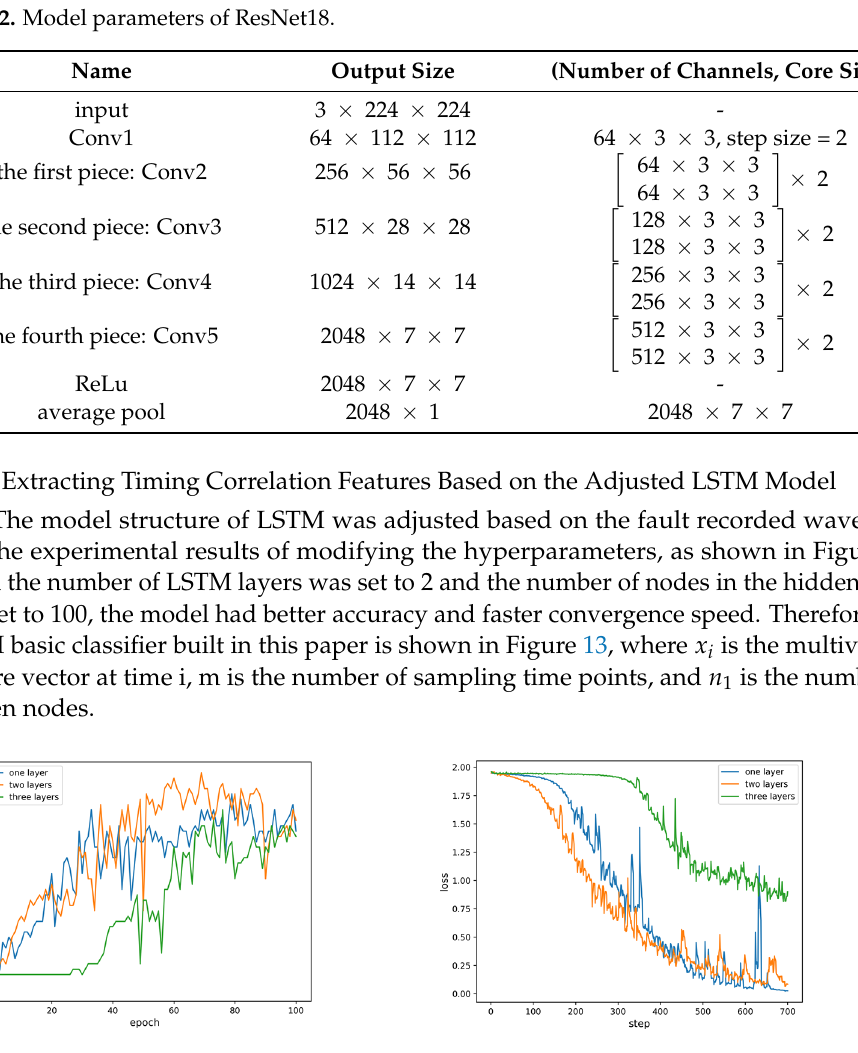
Figure 13. LSTM basic learner structure. The two basic classifiers can be trained in parallel, and the loss functions are both cross-entropy loss functions. 3.2.4. Construction of the Secondary Data Sets and Fusion Models For the two basic learners built herein, the ResNet18 model can extract the complex nonlinear features of the data set, and the LSTM model can extract the time series-related features. The secondary learner fuses and learns the complementary feature results ex- tracted by the two basic learners to generate the final classification result [43]. The second- ary classifier selected in this paper is the decision tree model. The decision tree algorithm can recursively select the optimal features of the sample, and segment the training data according to the feature, so that each subset of the data has a best classification result [44,45]. Moreover, its calculation is relatively simple, and no parameter assumptions are required. It is highly explanatory and easy to transform into classification rules as well as suitable for high-dimensional data [46]. The type of decision tree used in our methodology as the secondary classifier is the CART tree, which can handle continuous or discrete feature types. The criterion for se- lecting features is the Gini index. The calculation method of the Gini index is given below. 𝐺(𝑝) = (cid:3533) 𝑝 (cid:3038) (1 − 𝑝 (cid:3038) ) (cid:3012) (cid:3038)(cid:2880)(cid:2869) = 1 − (cid:3533) 𝑝 (cid:3038)(cid:2870)(cid:3012) (cid:3038)(cid:2880)(cid:2869)